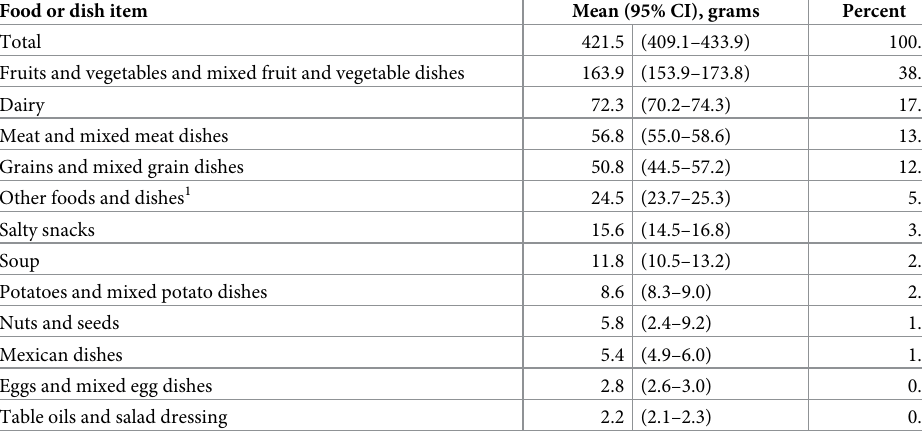
Table 1. Daily per capita food waste (n =